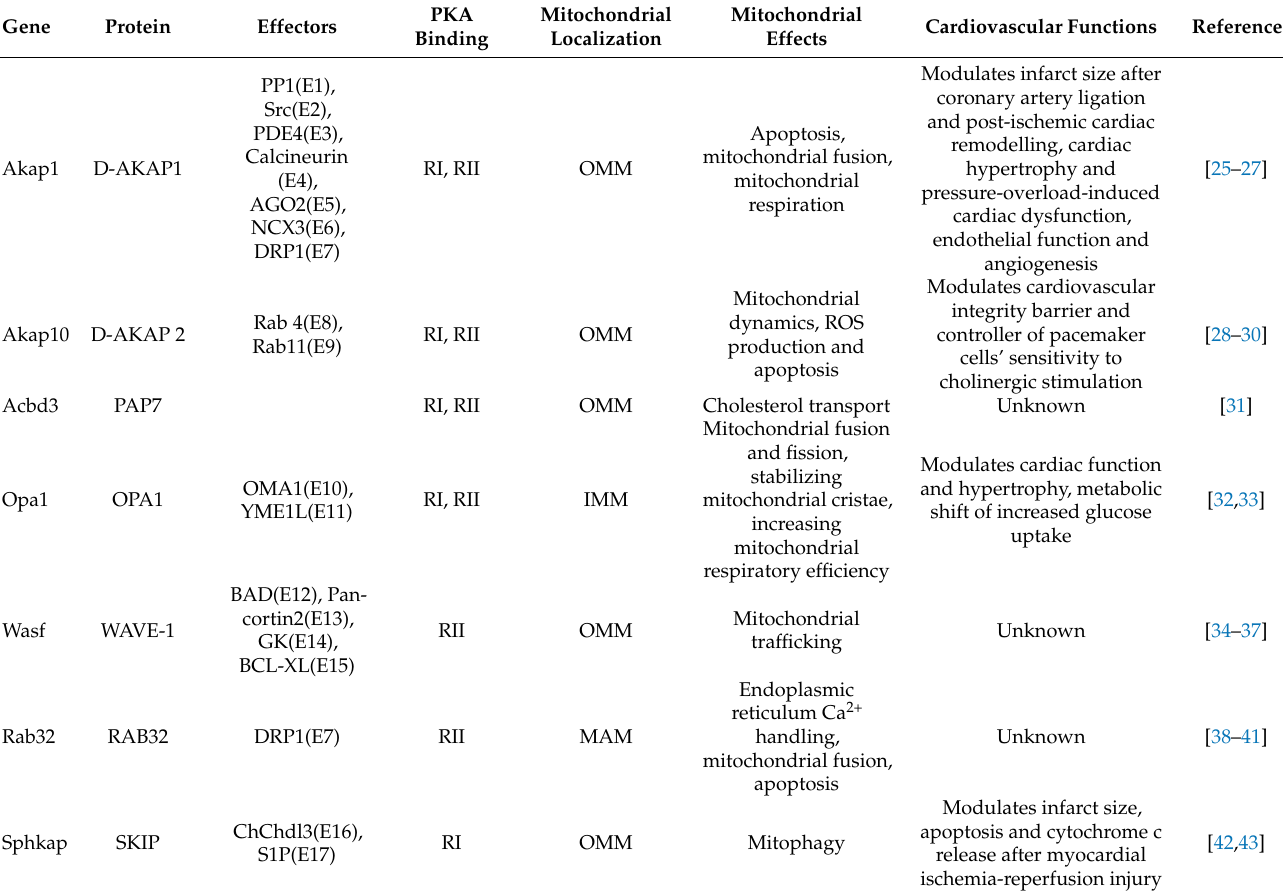
Table 1. Mitochondrial AKAPs and their known cardiovascular functions.